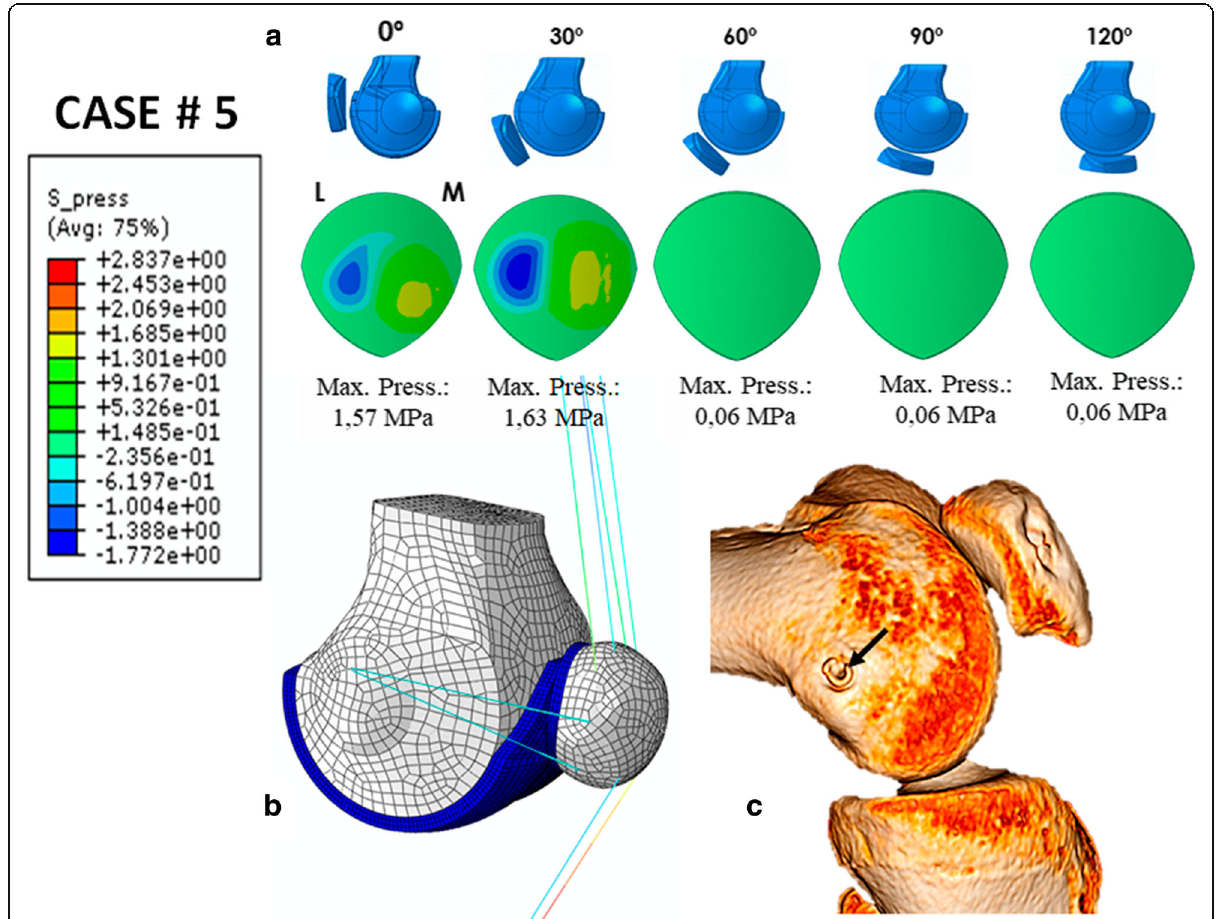
Fig. 8 Case # 5 Primary surgery with an excellent result: a Contact pressure (MPa) on the patella cartilage L = Lateral M = Medial. b Parametric model of patient # 5. c Anatomic femoral attachment point (black